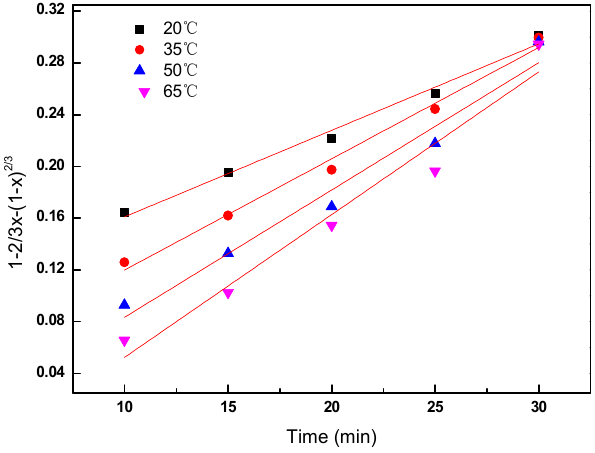
Figure 6. Arsenic removal kinetic at different reaction temperatures.